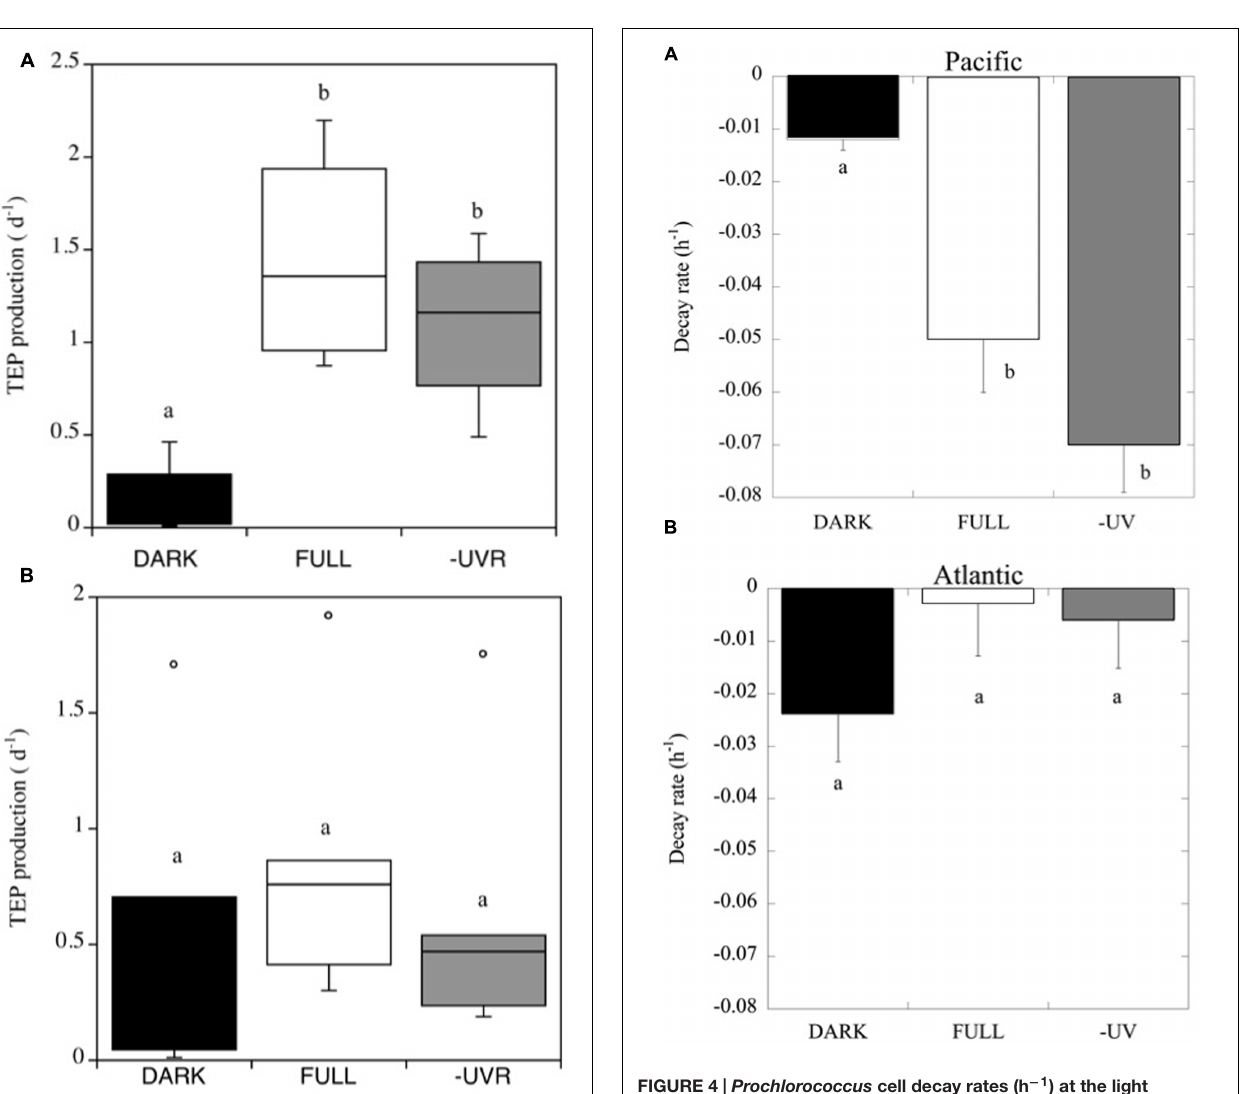
FIGURE 4 | Prochlorococcus cell decay rates (h − 1 ) at the light treatments FULL, DARK and –UV, as described in Figure 3. (A) Data from experiments with Pacific and (B) Atlantic communities. The boxes with the same letter are not significantly different ( p >